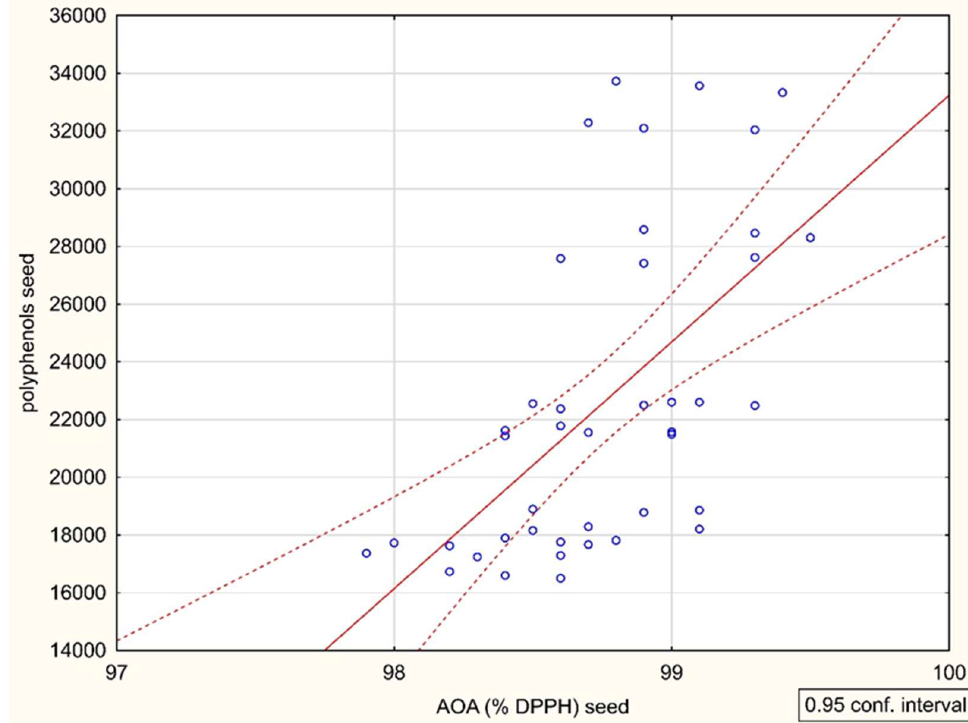
Figure 5. The correlation of AOA and TPC in okra seeds.